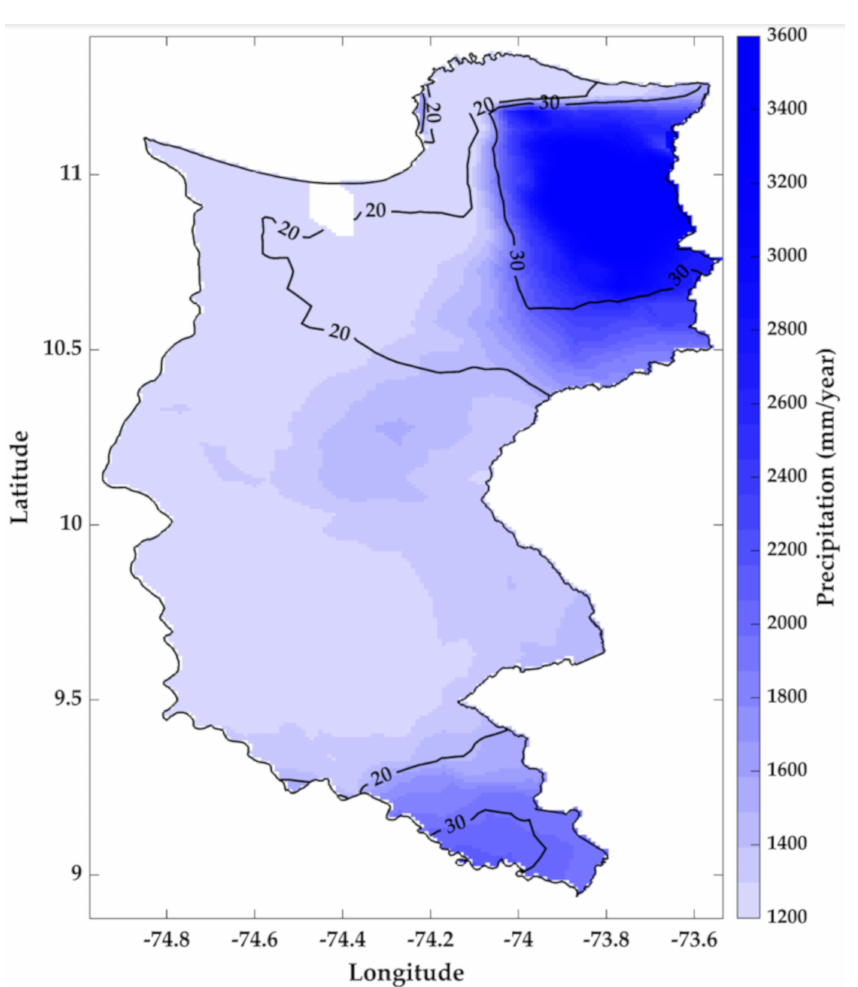
Figure 4. Spatial distribution of mean total annual precipitation in the Magdalena Department for the 1981–2018 period based on the CHIRPS v2.0 database. The contour lines represent the coefficient variation for this variable. It includes four subregions identified based on spatial distribution of the total annual precipitation average and the coefficient of